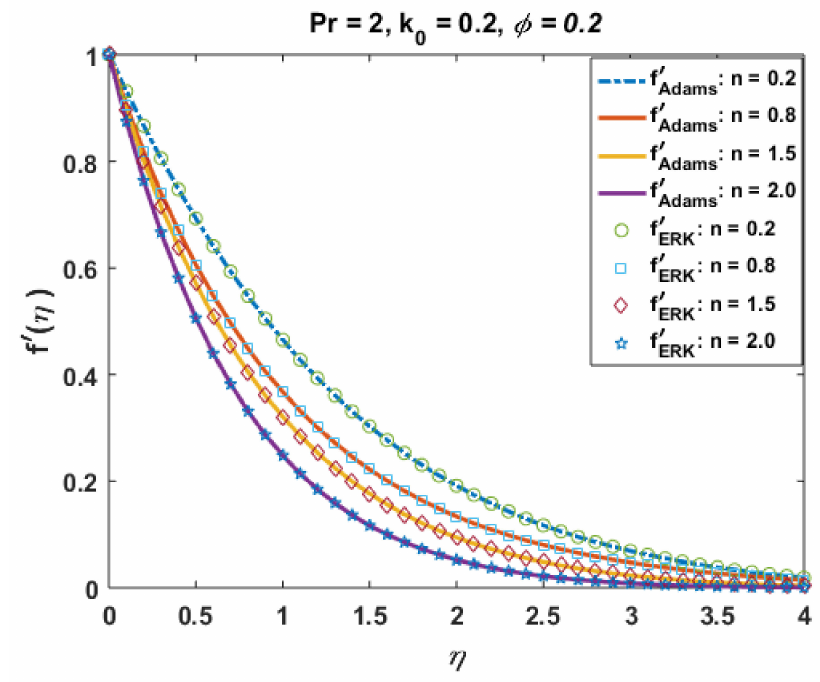
Figure 18. Effects of n on f (cid:48) ( η ) . Effects of n on profiles R and θ are portrayed in Figures 19 and 20. From these plots,